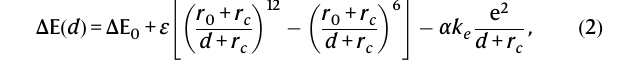
Fig. 2e – h and Supplementary Note 1, the equilibrium reaction CBMA +H 2 O =CBMAH + + OH − occurred in the hydrogel system. The